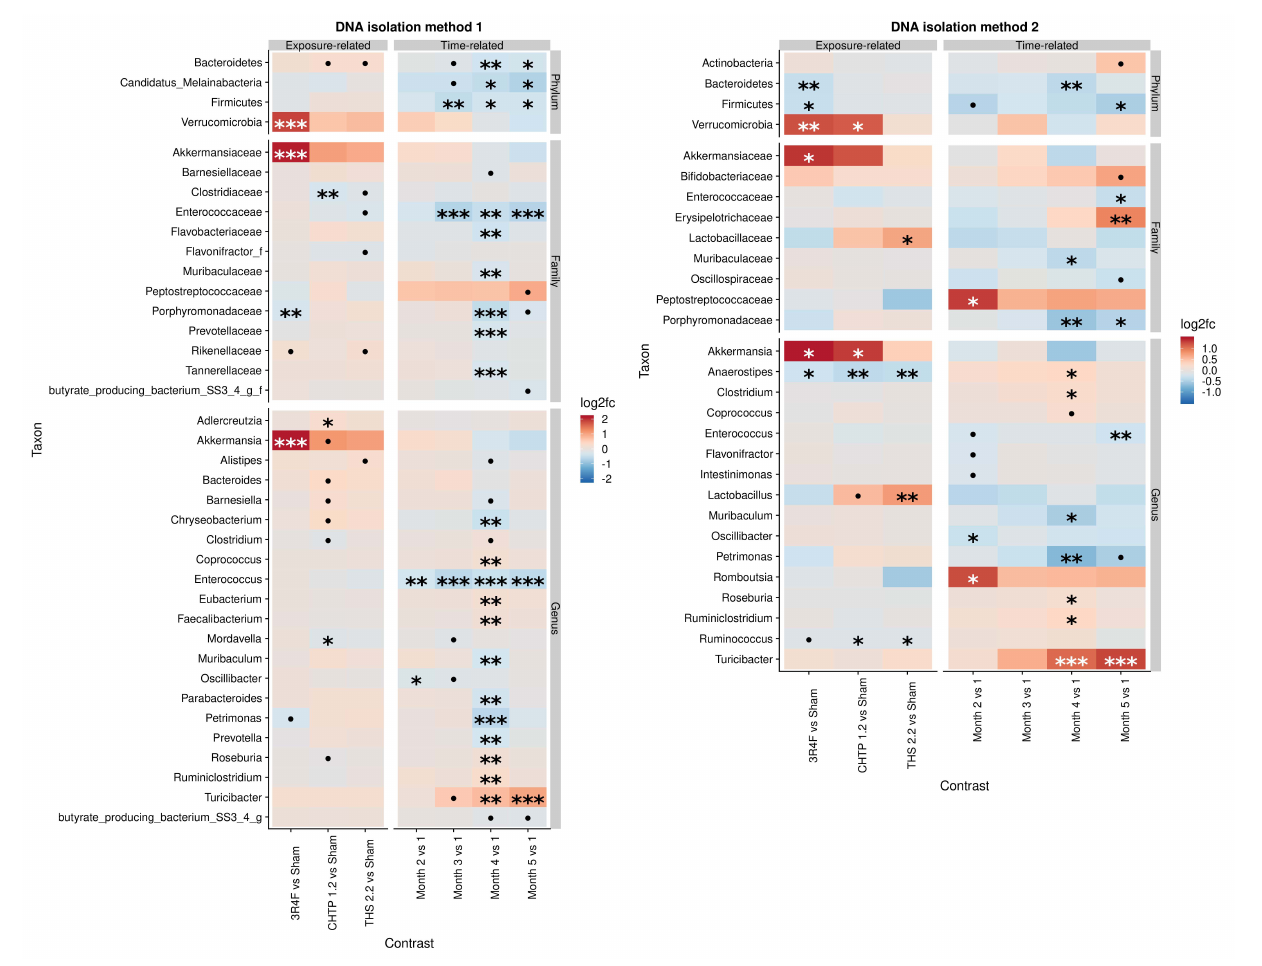
FIGURE 2 | Effects of 5-month continuous exposure on the fecal microbiome composition (excluding the switching groups) based on cage-wise sampling. Fold changes in the abundance of various microbial taxa (y-axis) are modeled as a function of exposure type relative to the sham group and time point relative to the first time point (month 1). Two methods of DNA isolation were used for different samples collected from the cages. Significance values are indicated as follows: *** p ≤ 0.001; **0.001 < p ≤ 0.01; *0.01 < p < 0.05; *0.05 < p <